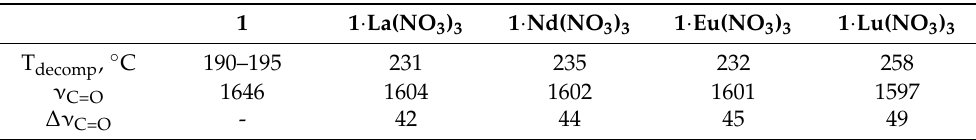
Table 5. Some characteristics of 1 · Ln(NO 3 ) 3 complexes.